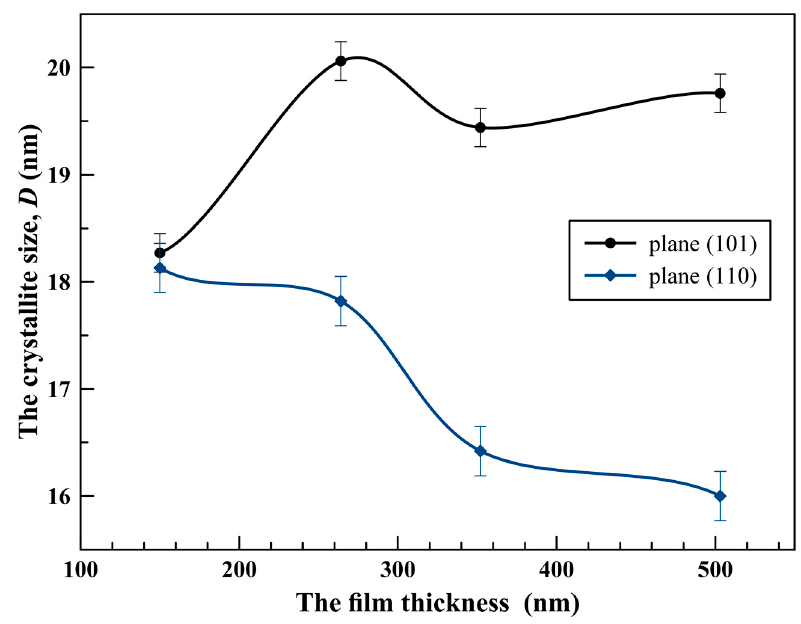
Figure 2. The variation of the crystallite size as a function of thin film thickness.